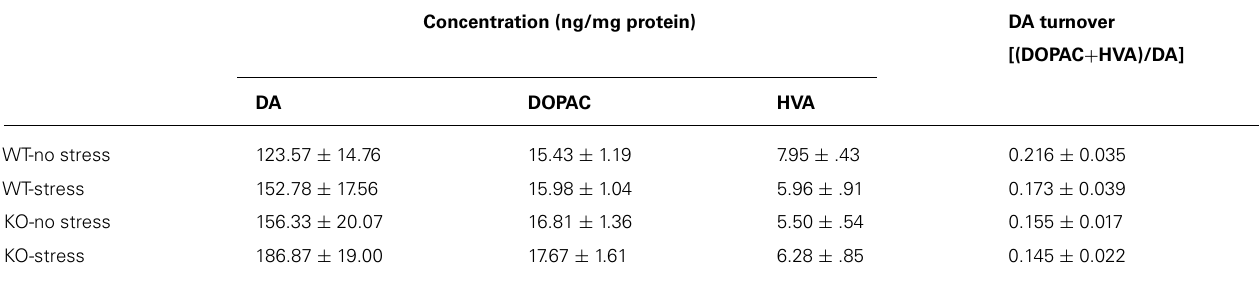
Table 3 | Dopaminergic activity within the nucleus accumbens as a function of chronic stress and IFN- γ deletion.